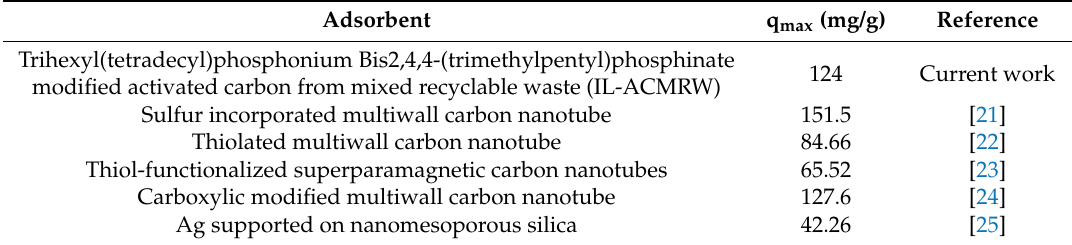
Table 3. Comparison of the ability of various adsorbent for Hg(II) uptake with IL-ACMRW (ionic liquid modified activated carbon from mixed recyclable